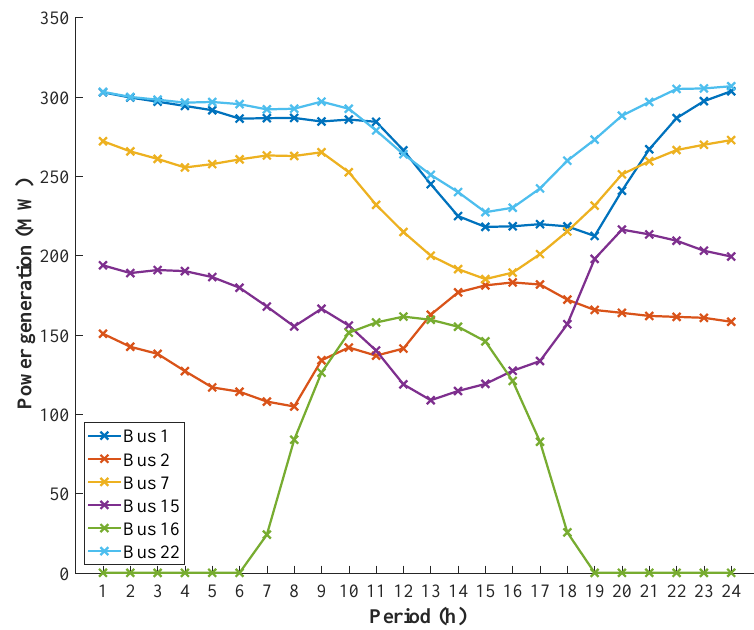
Figure 5. Wind and photovoltaic power generation values. Data source: